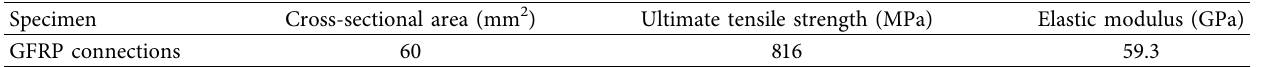
Figure 1: Schematic diagram of “thermal insulation” integrated wall board in bungalow. (a) “Thermal insulation“ integrated wall. (b) Schematic illustration of bungalow construction. Table 1: Test results of tensile properties of connectors.